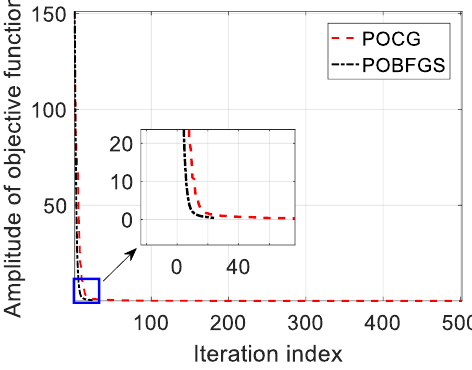
Figure 5. The results of resisting the VDJ using the different methods. ( a ) Comparison of random phase and POCG. ( b ) Comparison of random phase and POCG.